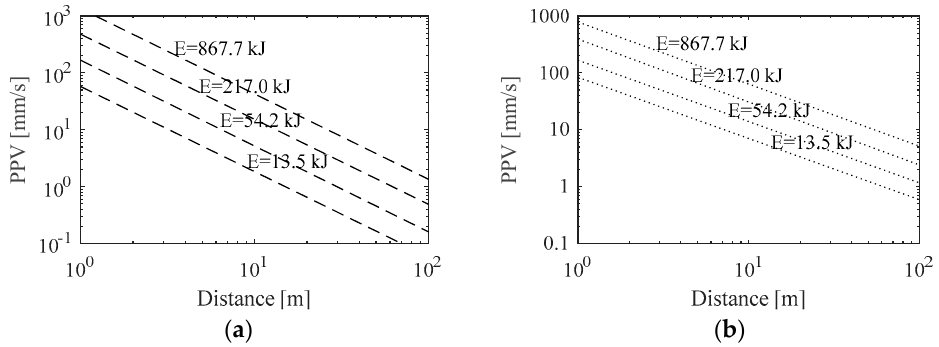
Figure 2. Predicted vibration levels for different types of soil: ( a ) Class II; ( b ) Class III (reported in FHWA [10]).